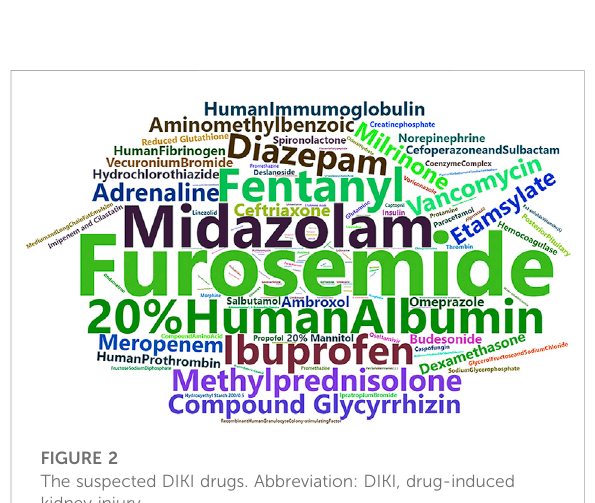
FIGURE 2 The suspected DIKI drugs. Abbreviation: DIKI, drug-induced kidney